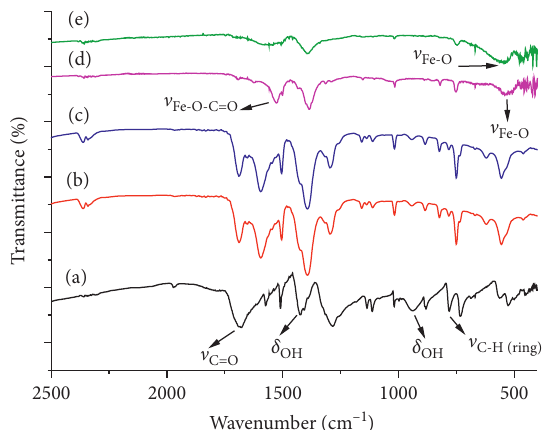
3 /TA molar ratio of 1:1 (a and b) and 1 :2 (c and d).